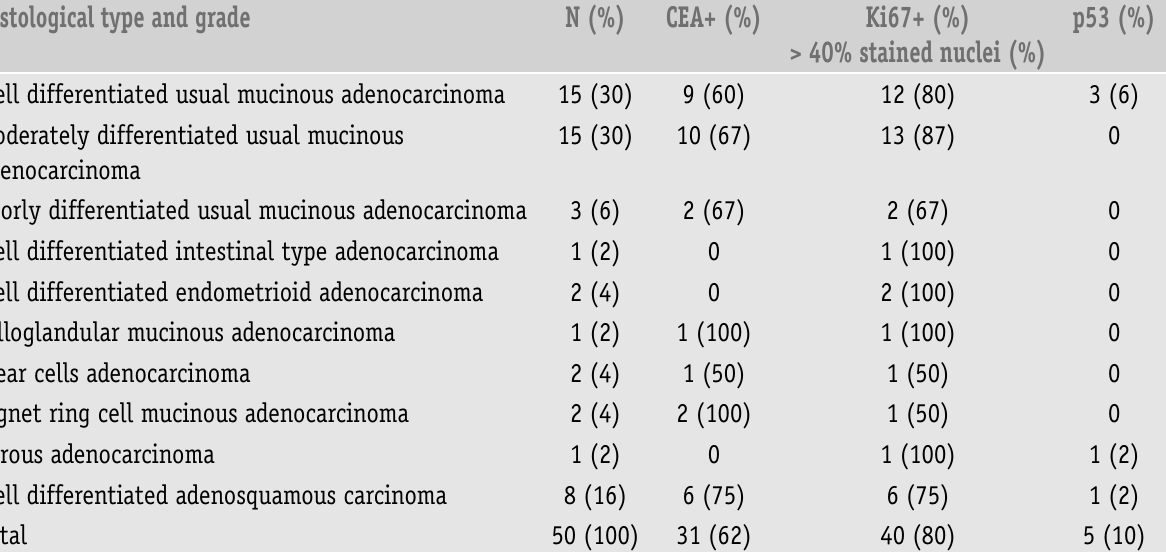
the effects of endogenous or exogenous hormones. On the other hand, Greeley et al . (13) , in 1995, concluded that there was no statistically significant relationship between MGH and the use of the pill, and found 57.9% of the cases of MGH and 47.4% of the control (without MGH) associated to the influence of hormones.